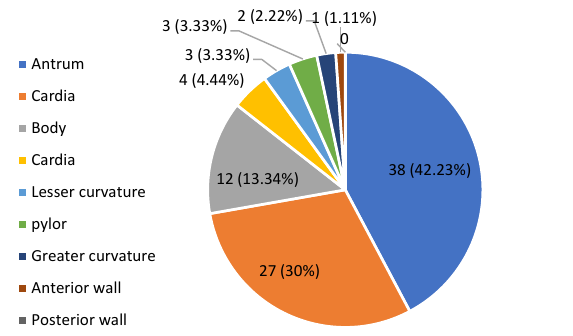
The histological type of adenocarcinoma was reported in 136 cases. The highest prevalence was related to poorly differentiated (n = 57, P = 41.94), poorly differentiated with signet ring features (n = Figure 2. Percentage of Anatomical Exact Location Reports. 31, P = 22.79), and (n = 19, P = 13.97), respectively (Figure 3).